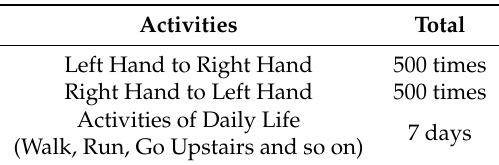
Table 6. Experimental dataset for recognizing the hand-changing process employing pattern recognition